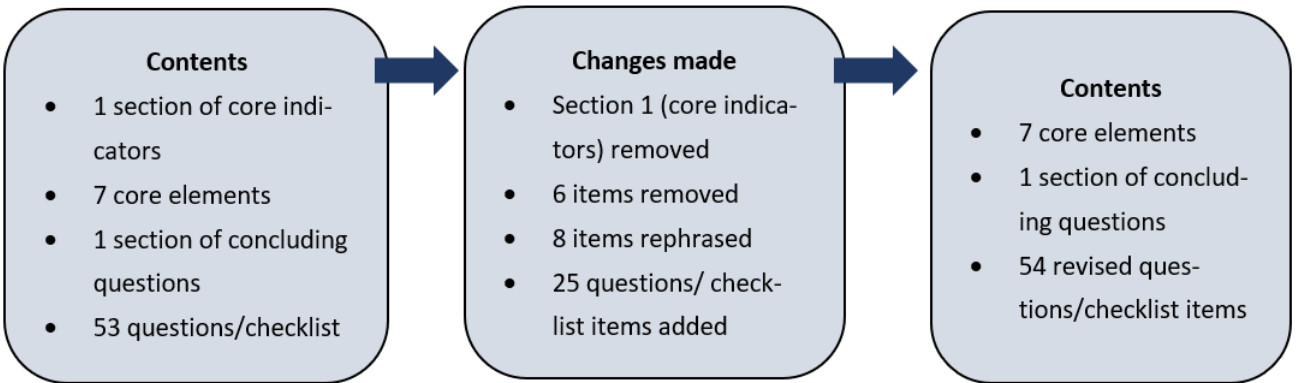
Figure 1. Summary of consensus process